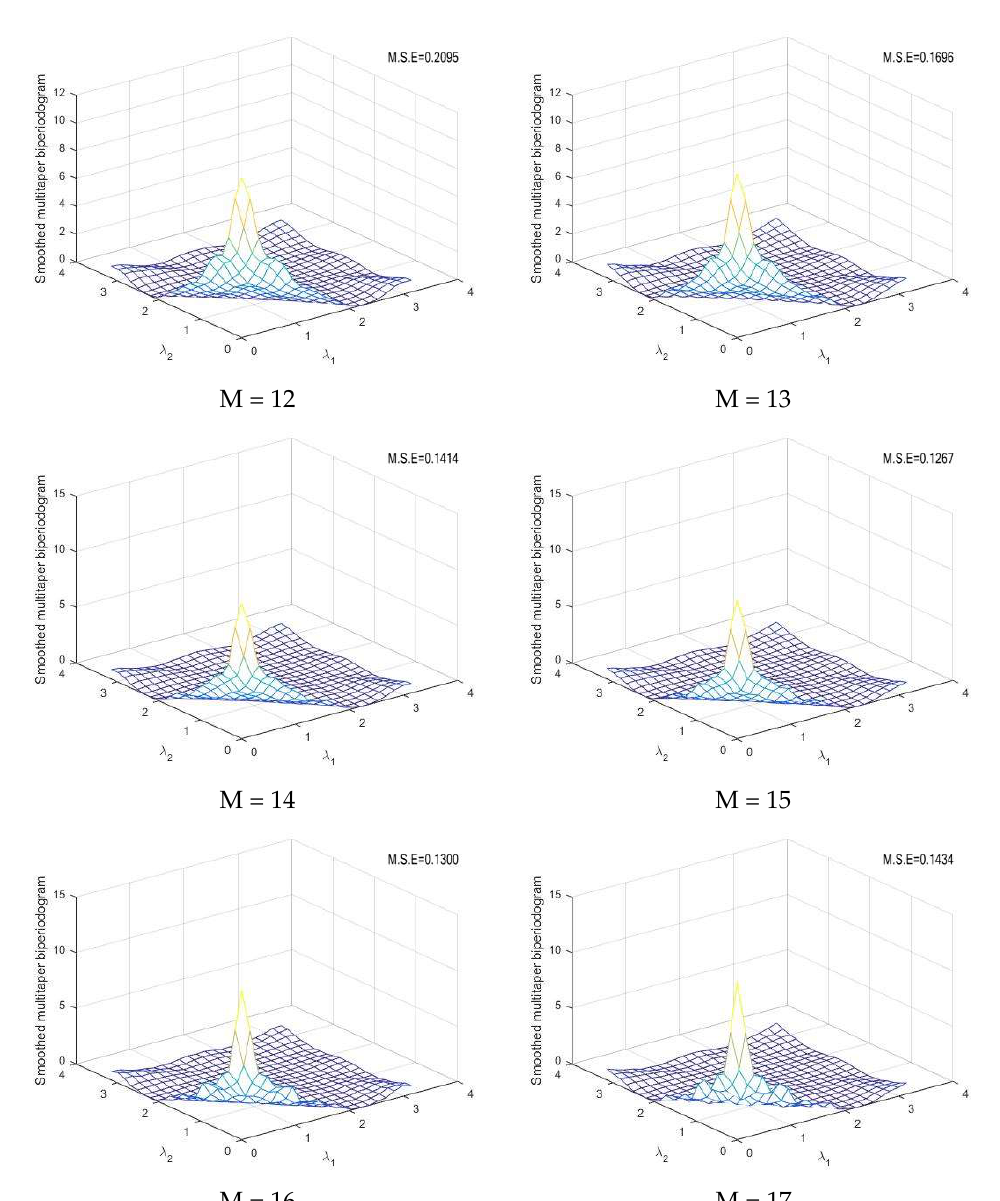
Figure 4. Smoothed multitaper biperiodogram at different values of M